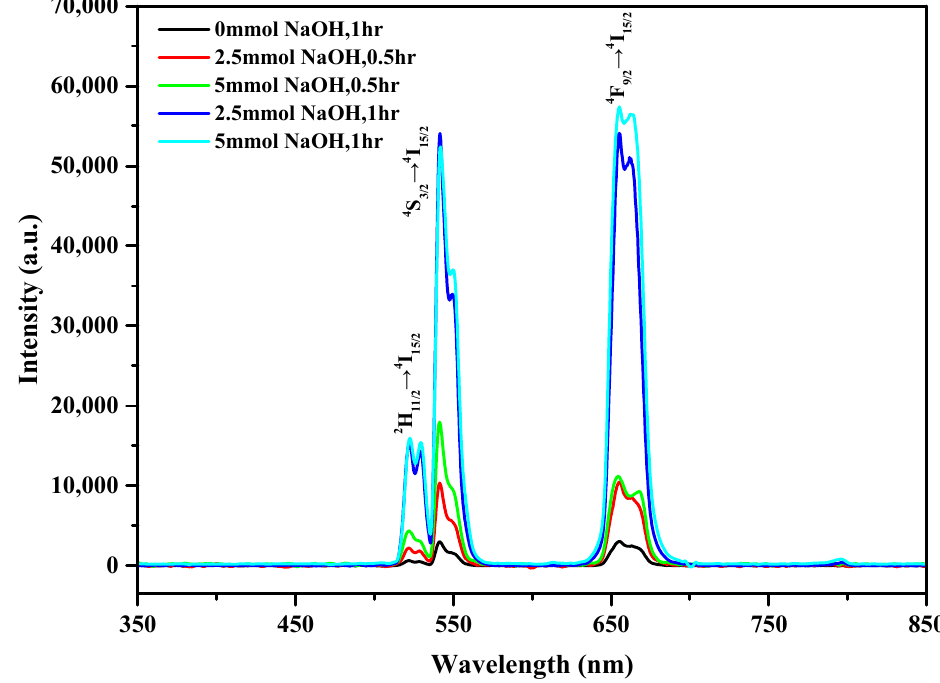
Figure 4. Photoluminescence spectra of LaF 3 :Yb 3 + 0.20 , Er 3 + 0.02 core upconversion nanoparticles (UCNPs) under 980 nm excitation